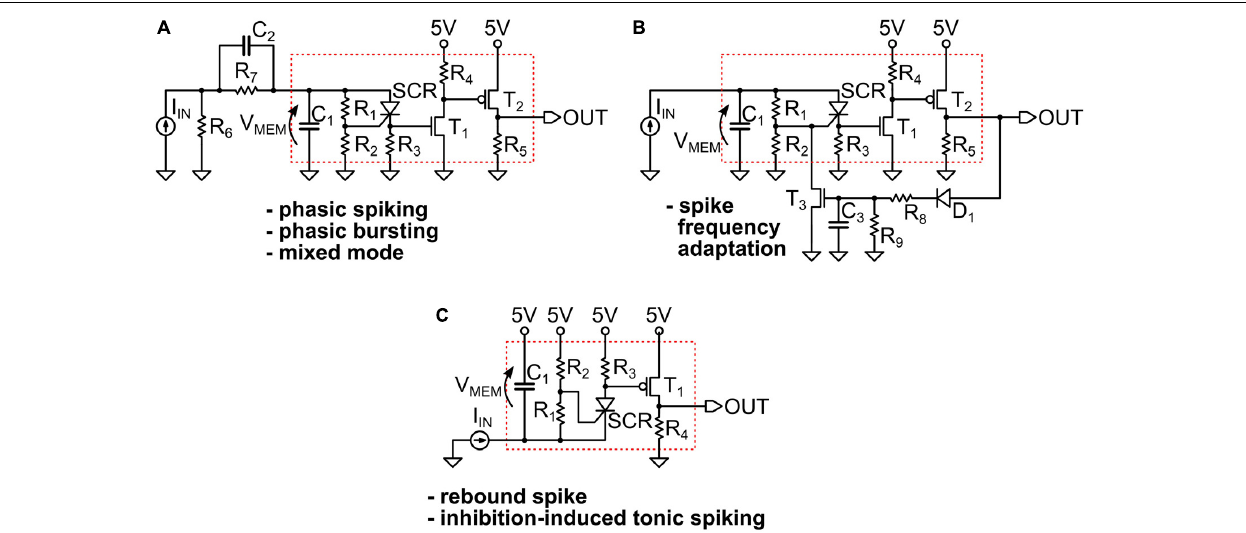
FIGURE 3 | (A,B) The circuits that implement the simulated spiking behaviors shown in the Figure 2 of the main text. They all represent small variants of a basic UCN circuit block that is indicated by a red dotted line box. We indicate with an arrow the definition of the “membrane” voltage V MEM on the capacitor C 1 . The circuit adapted for negative input is shown in (C) , where we indicate with a red box the basic UCN block that is slightly modified with respect to the original. Note that the rebound spike may also be called inhibition-induced phasic spike. The specific values of the components are provided in Supplementary Material